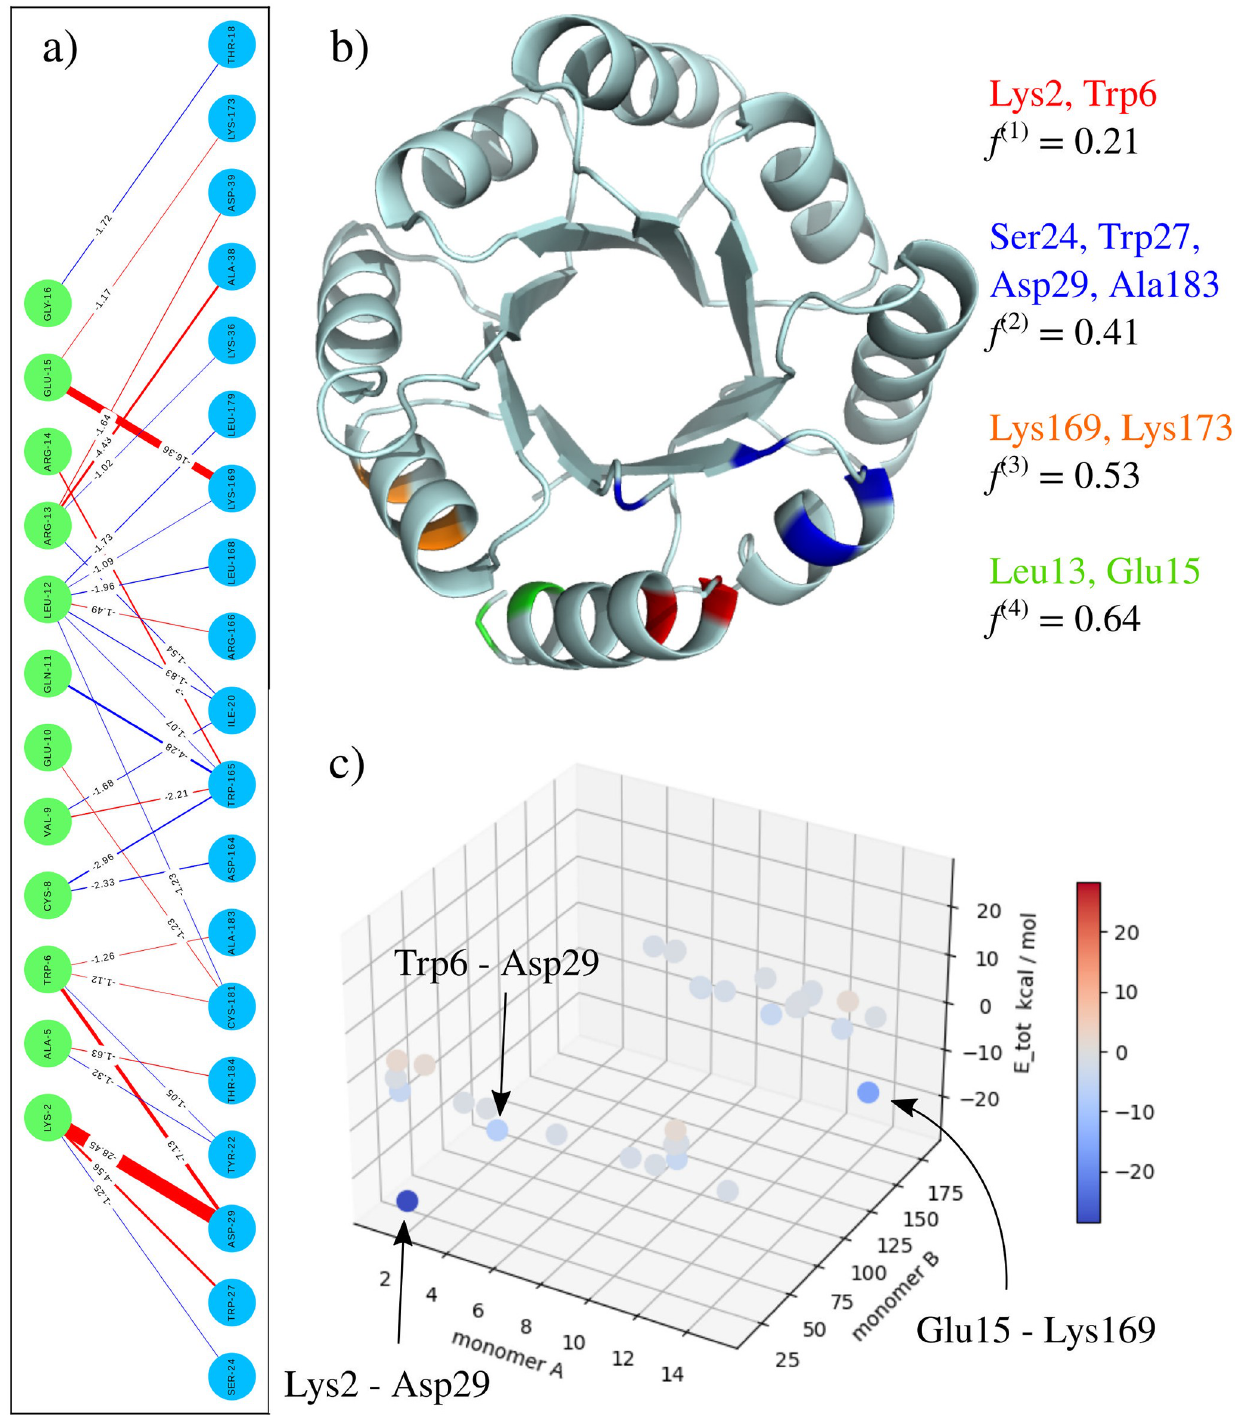
Fig 4. PPI analysis in pyProGA. a) The attractive G PPI . Green monomer A, blue B. Thickness of edge corresponds to interaction strength, colour to character; red for prevailing electrostatic, blue for dispersion, see [85]. b) First four most dominant principal coordinates (interaction motifs in the PPI) as identified by the SVD analysis of G PPI . Colour coded assignment of residues to PC. Factor f ( r ) is defined by Eq 3. c) 3D-SPIE plot helps to identify strongest attractive and repulsive interactions between monomers A and B. More details in S1 File.